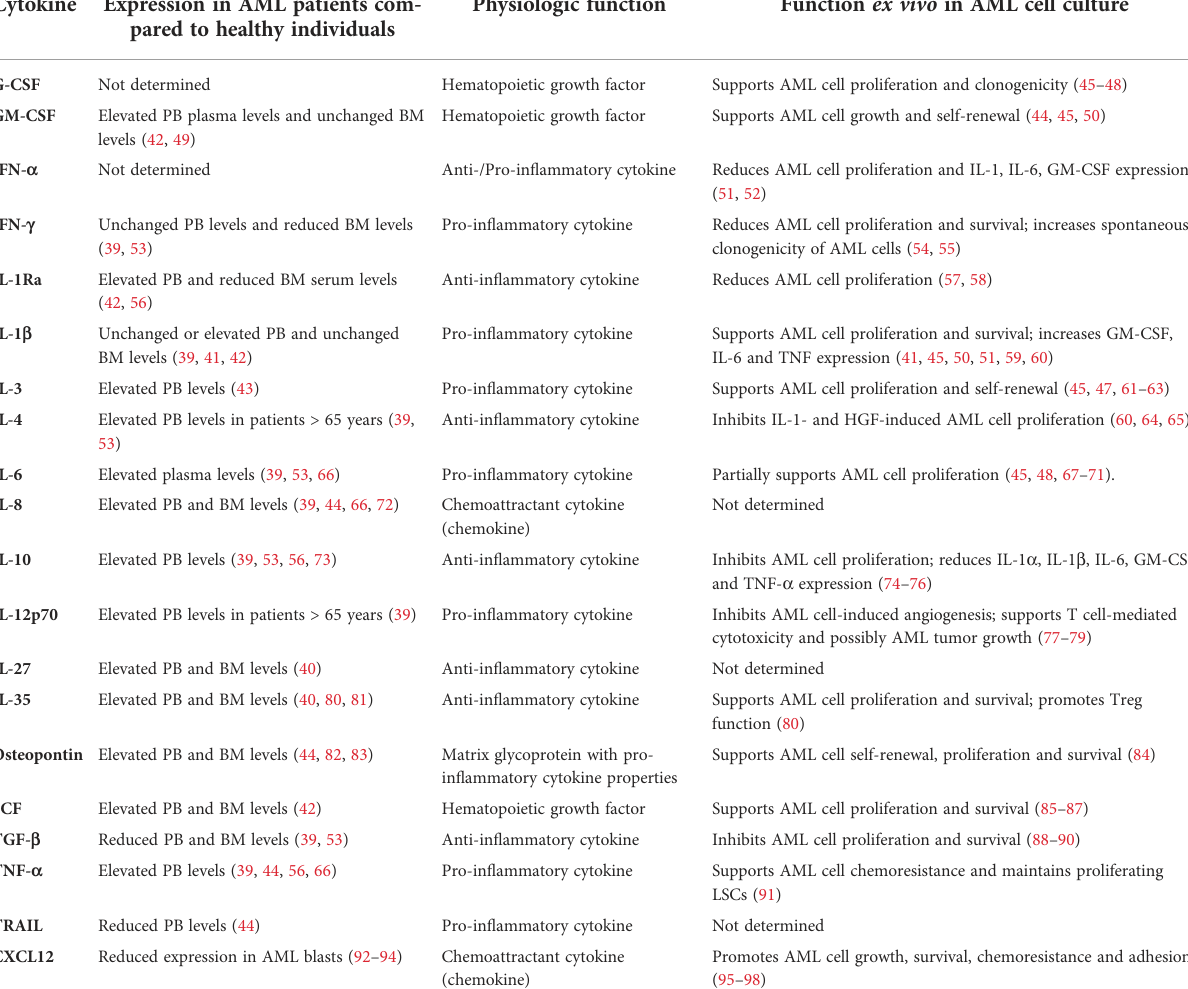
TABLE 1 Cytokines and growth factors supporting or inhibiting AML